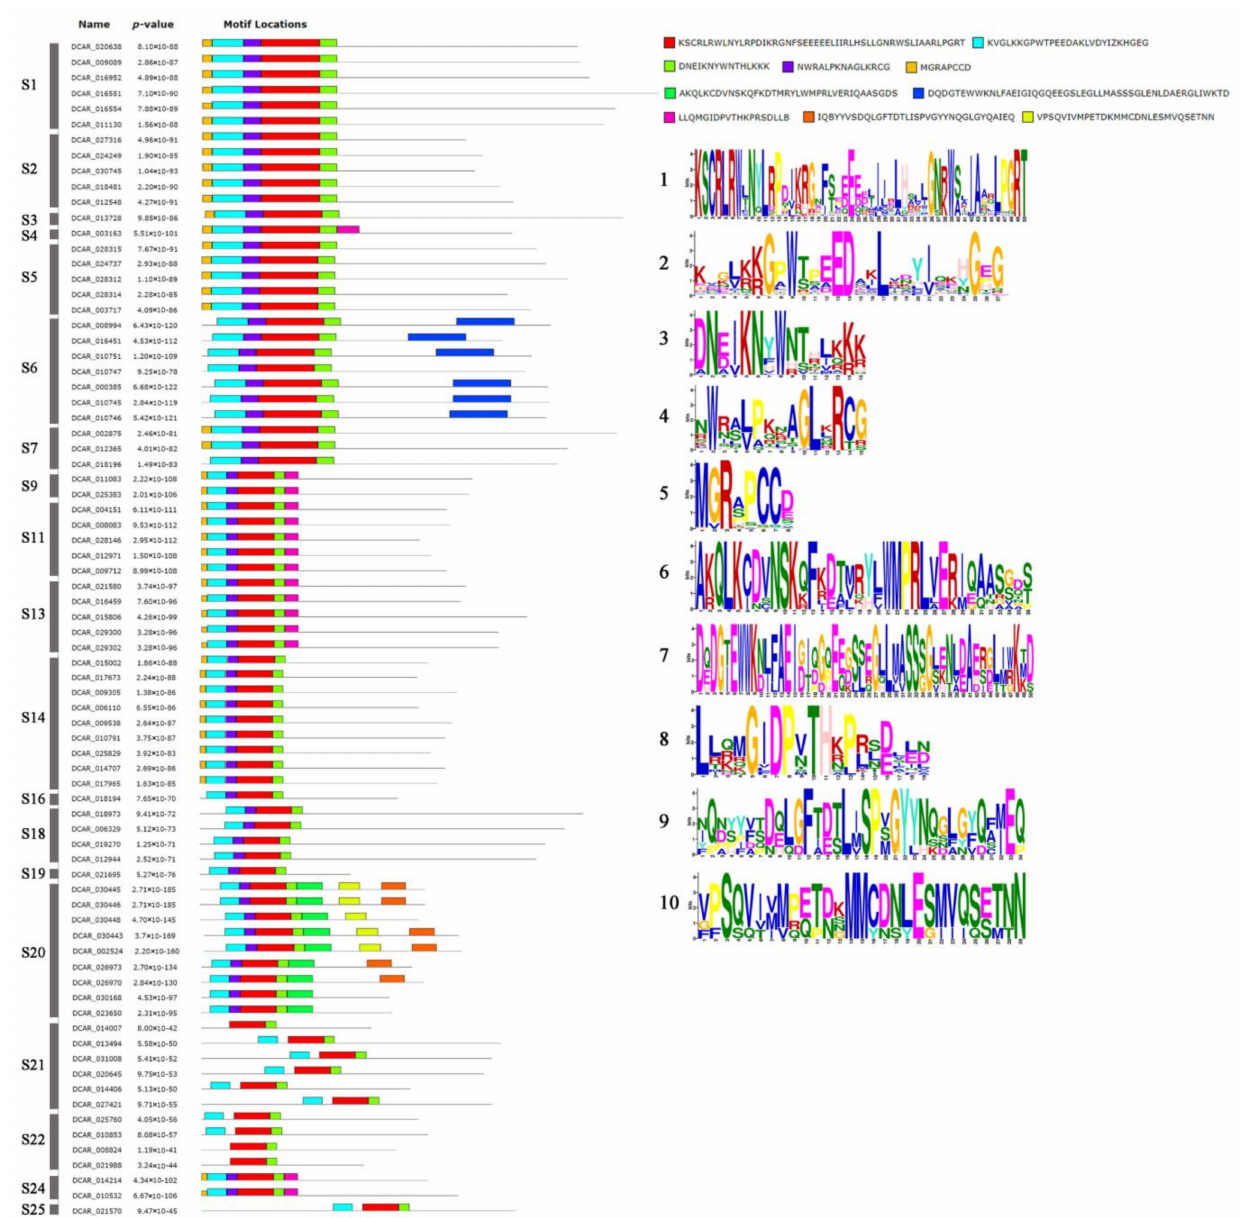
Figure 4. Sequence logos of conserved domains of R2R3-MYB proteins in